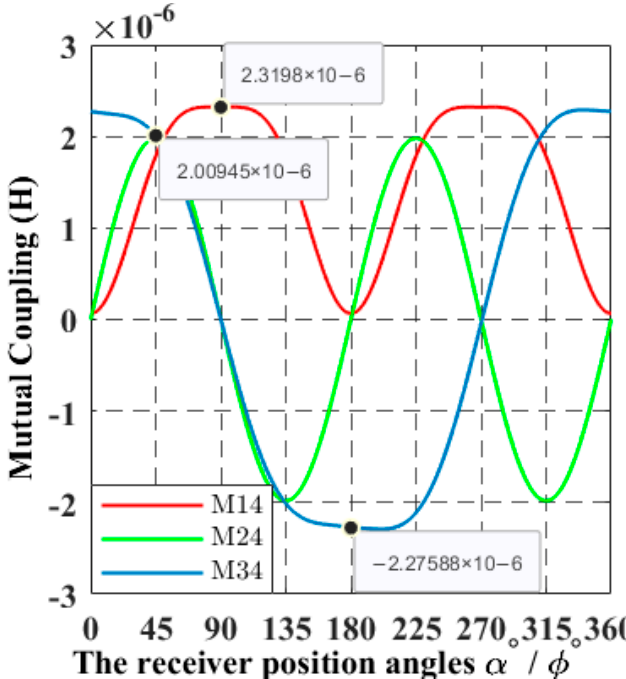
Figure 5. The mutual coupling curves when the receiver coil position angles α and φ are rotating from 0° to 360° through a 1° step change at a distance of 0.3 m.